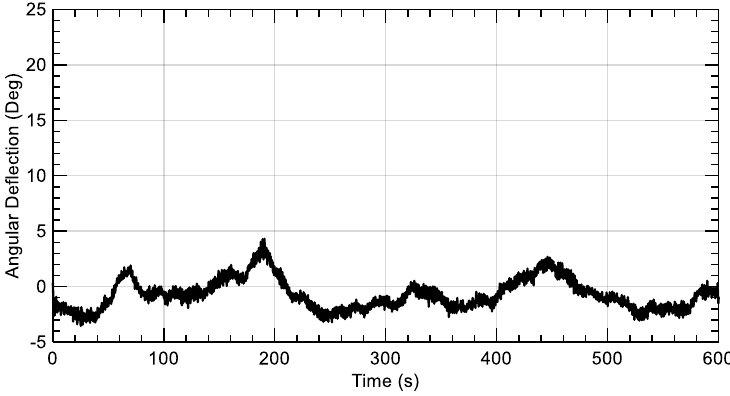
Figure 28. Tower top yawing deflection: turb. class B.